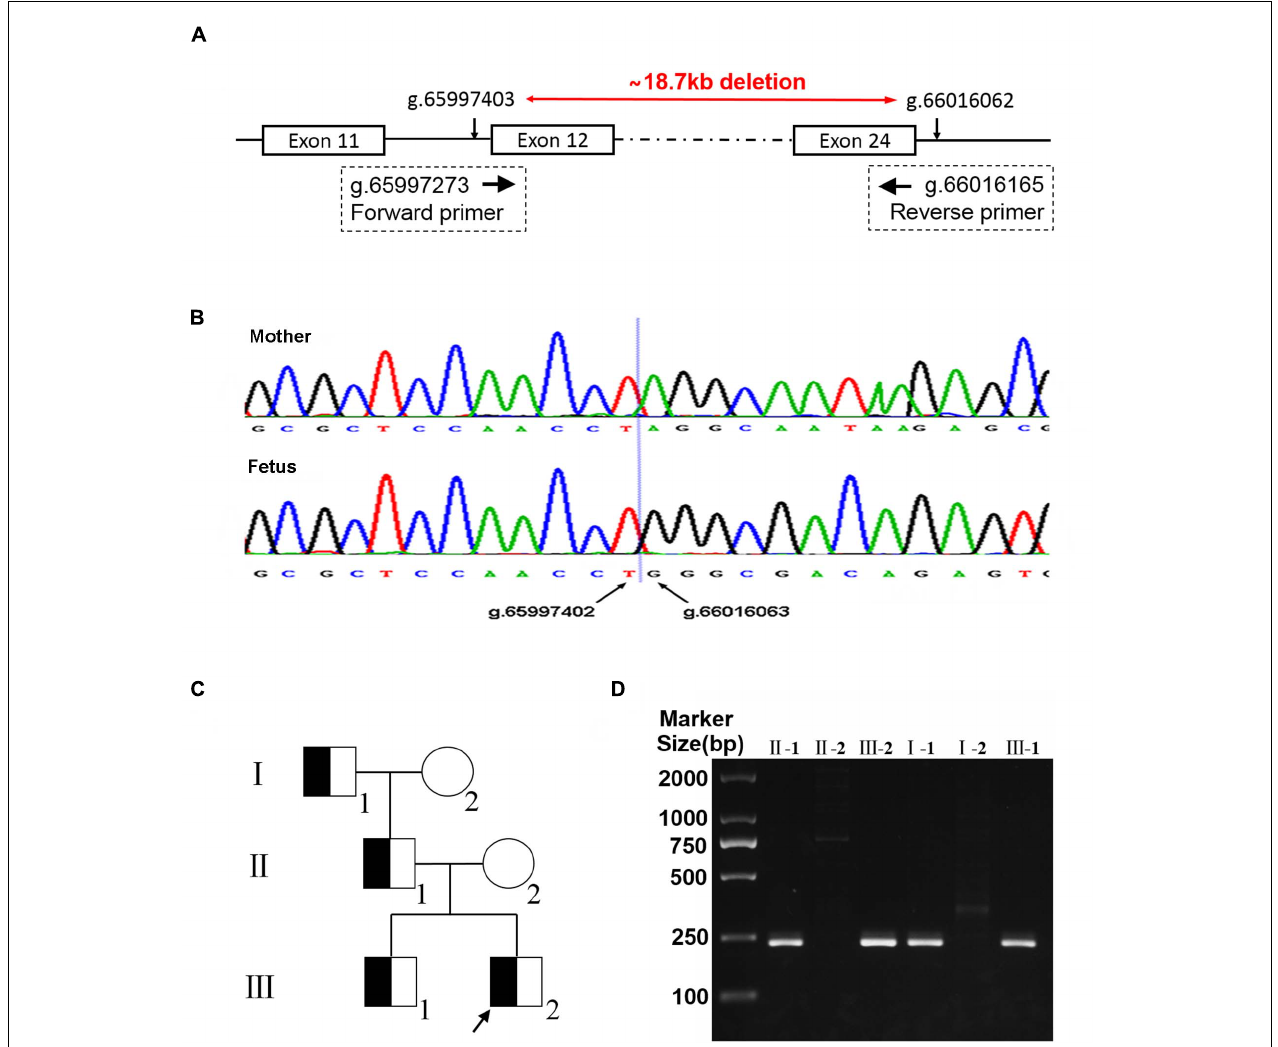
FIGURE 2 | Primers that flank the deletion breakpoints were designed for gap-PCR (A) . Deletion of exons 12–24 was validated by Sanger sequencing. An 18,660-bp deletion covering exons 12–24 in PACS1 was identified (Chr11:65997403-66016062; hg19, GRCh37; B ). Pedigree of individuals with exons 12–24 deletion in this three-generation family. The variation of the proband (current fetus, III-2) and his elder brother (III-1) was inherited from their father (II-1) and which was derived from their grandfather (I-2; C ). Electrophoresis of gap-PCR products. The presence of a 233-bp band indicated the carrier of the multi-exon deletion in PACS1 (D)